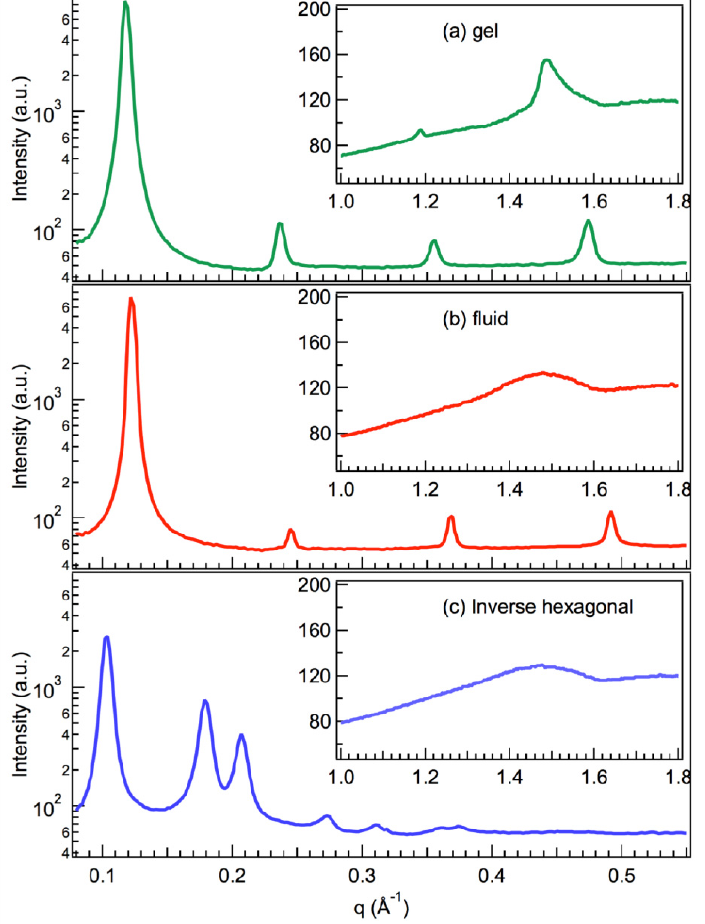
Figure 3. Radial averages of the data in Figure 2, plotted as intensity vs . q . The positions of the peaks determine the phase and relevant structural parameters. For the ( a ) gel and ( b ) fluid phases, the primary peak at low q determines the repeat spacing, d (Figure 1a). As both samples are lamellar, the higher order peaks are the second, third, fourth and fifth order reflections of this primary repeat spacing. For the ( c ) inverse hexagonal phase, the reflections yield d and d . The wide-angle peaks (shown in the insets) yield the average 11 10 chain-chain separation. The sharp peak in ( a ) is indicative of the ordered gel phase, while the other two samples have chains in the fluid configuration, giving a broad